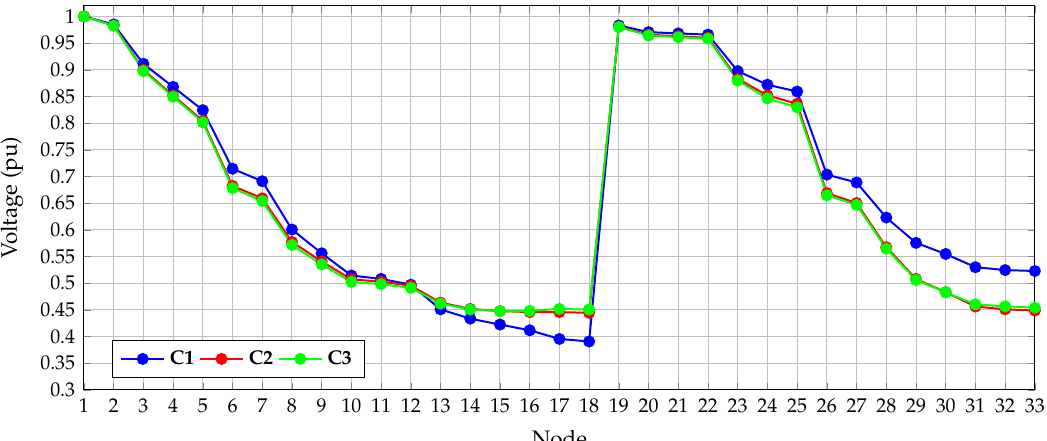
Figure 5. Behavior of the voltage profiles in the benchmark case, i.e., C1, and simulation cases C2 and C3 with three dispersed generators for the IEEE 33-bus